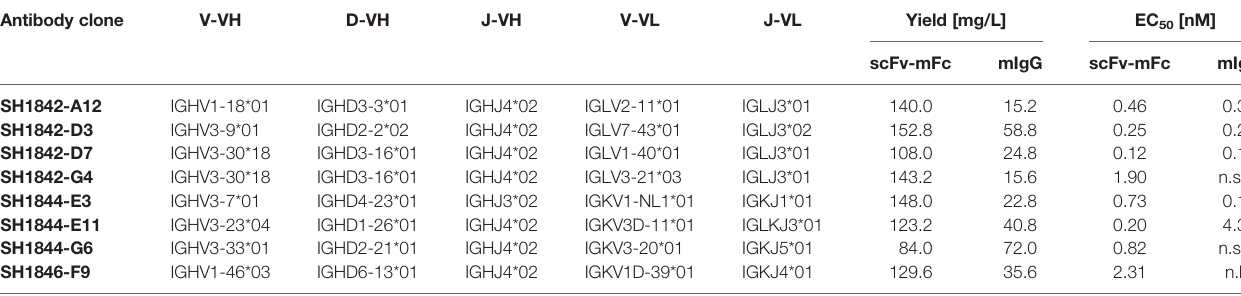
Antibodies from various gene families were produced as mIgG2a-Fc fusion or full mIgG2a in Expi293F suspension cells. Yield values are extrapolated from 50 mL scale. “ n.s.b. ” indicates non-sigmoidal weak binding. No binding is abbreviated as “ n.b. ” . The asterisk is typically used for indicating the allele of an antibody gene.